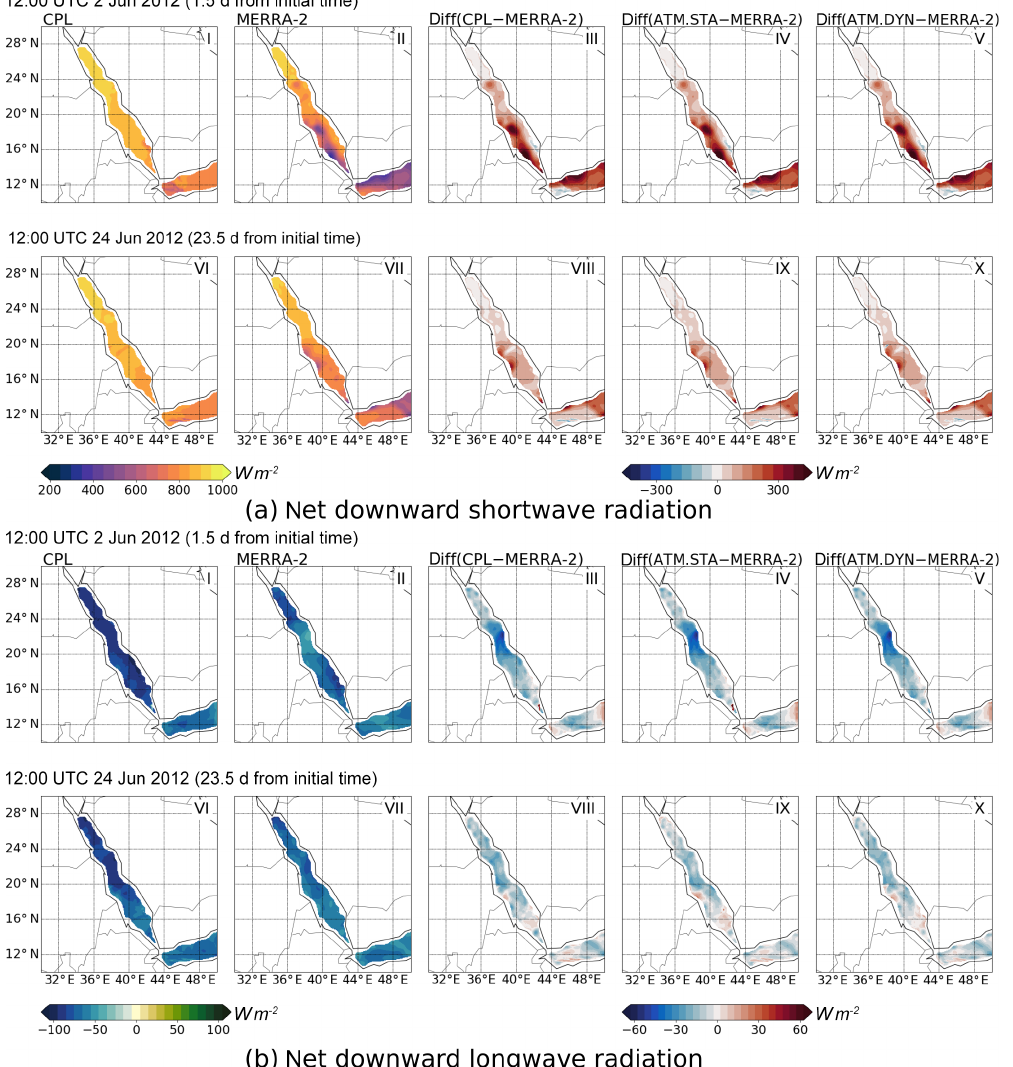
Figure A2. The net downward shortwave and longwave radiation obtained in CPL, MERRA-2 data, and their difference (CPL − MERRA- 2). The differences between ATM.STA and ATM.DYN with MERRA-2 (i.e., ATM.STA − MERRA-2, ATM.DYN − MERRA-2) are also presented. Two snapshots are selected: (1) 12:00UTC 2 June 2012 and (2) 12:00UTC 24 June 2012. The simulation initial time is 00:00UTC 1 June 2012 for both snapshots. Only the heat fluxes over the sea are shown to validate the coupled